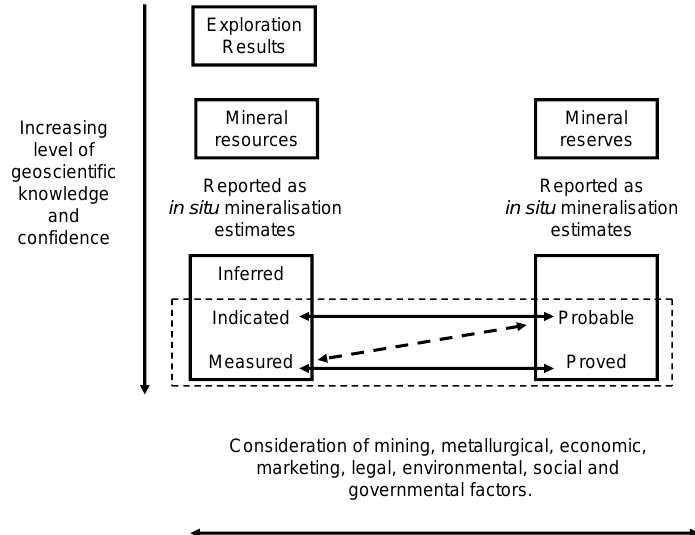
FIGURE 1: Relationship between exploration results, mineral resources and mineral reserves